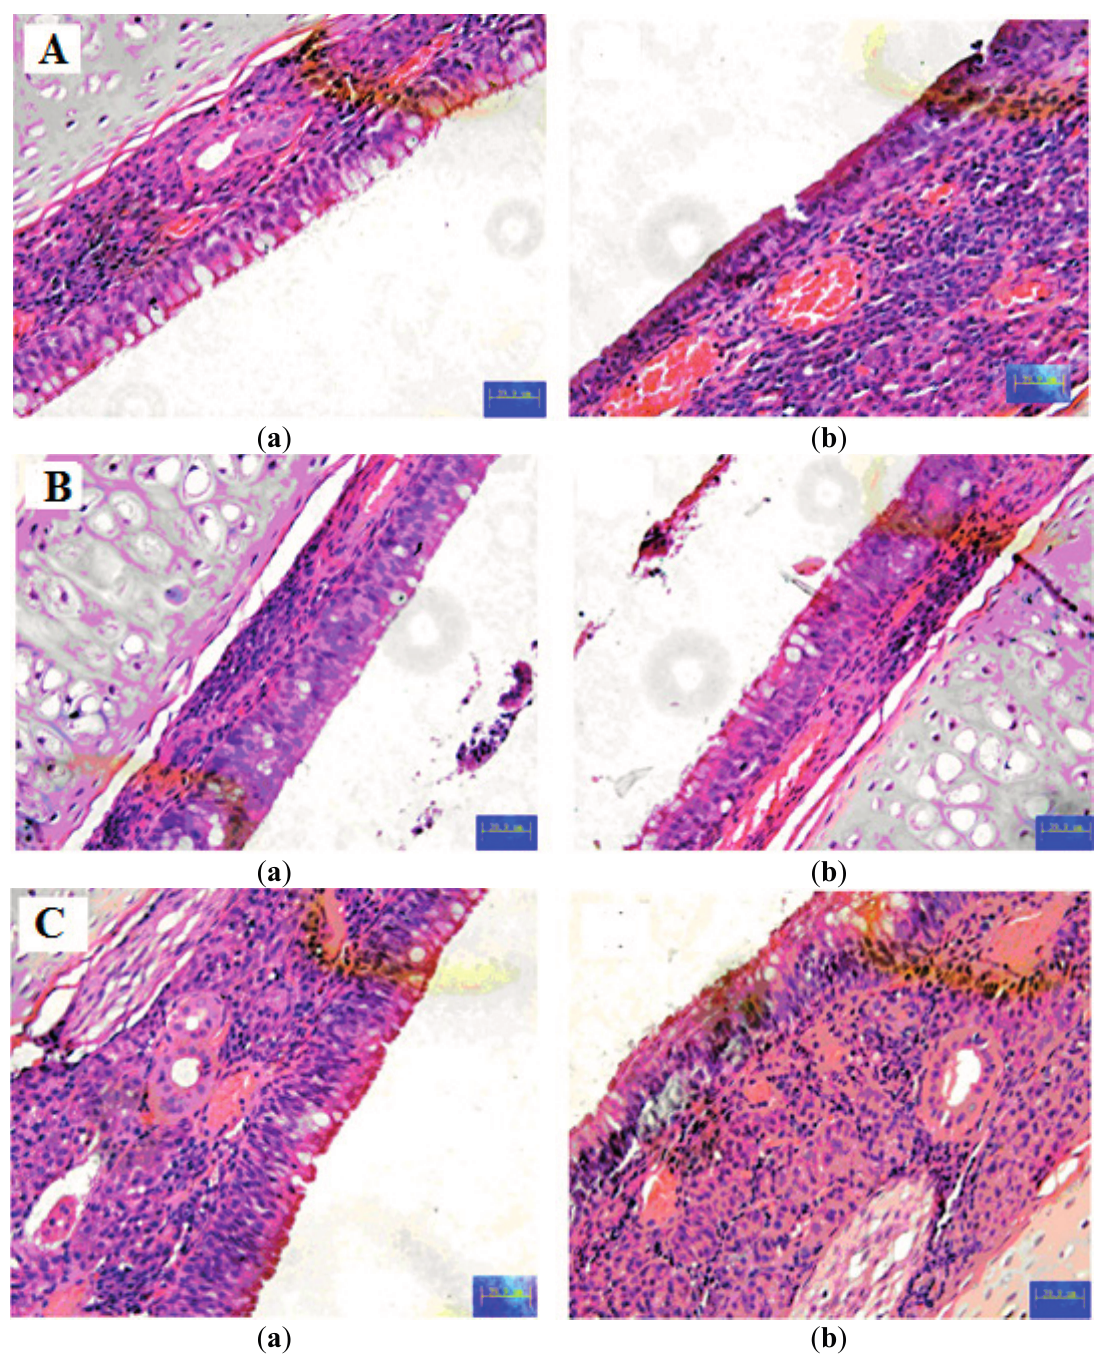
Figure 5. Histopathological studies of stomach ( A ) small intestine ( B ) and colon ( C ). ( a ) Saline and ( b ) BUD microspheres. Scale bar: 2